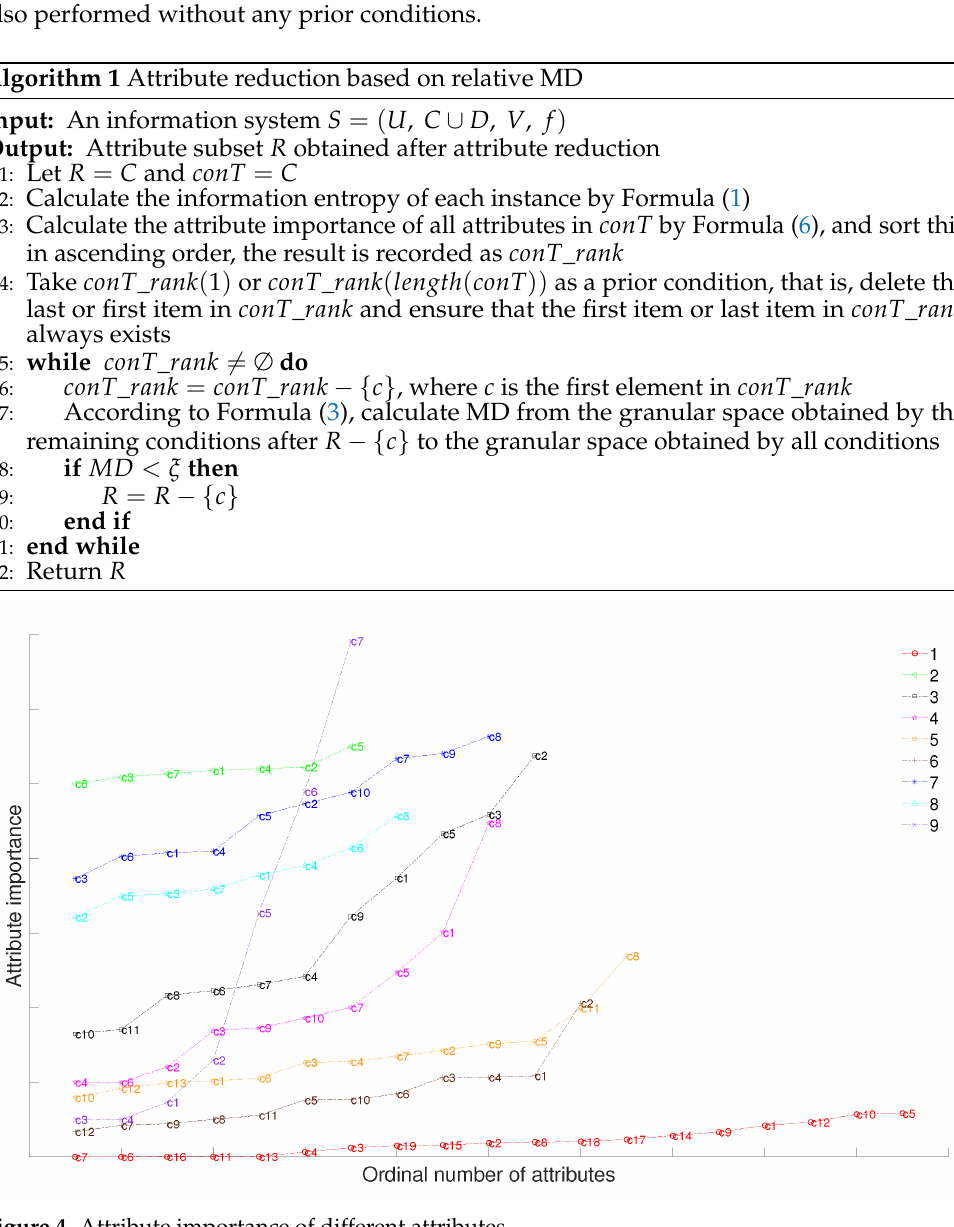
Figure 4. Attribute importance of different